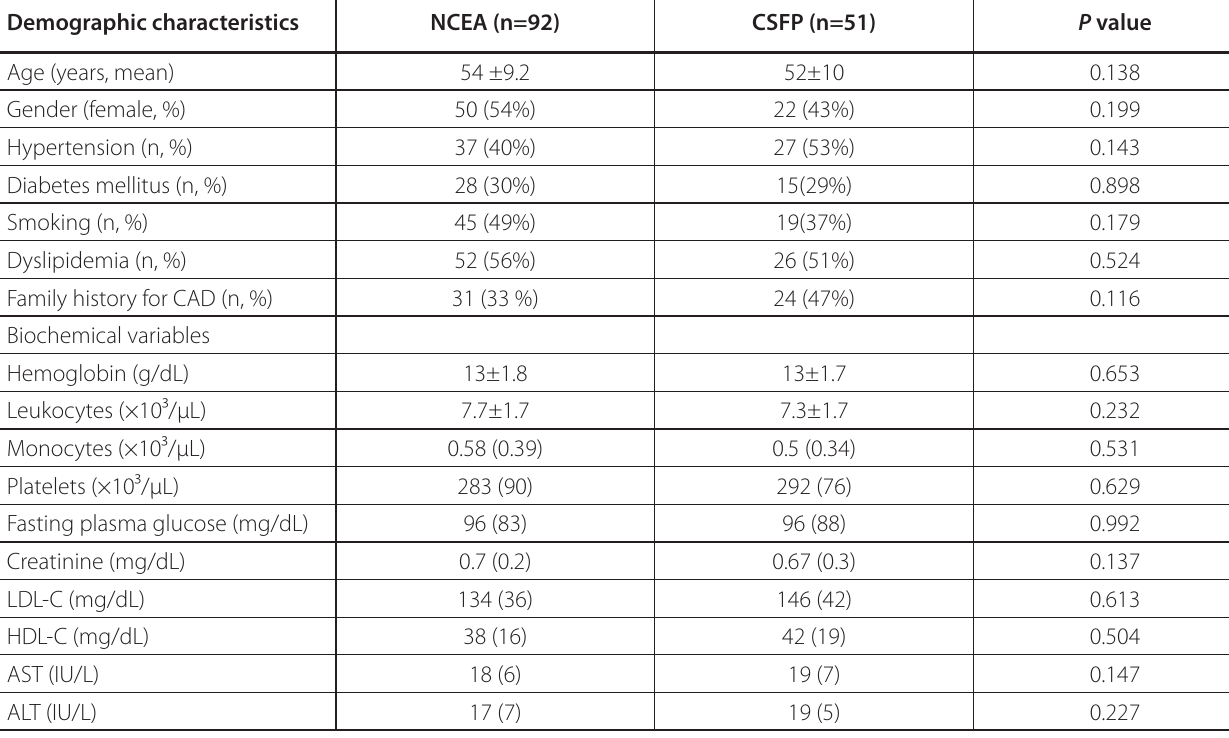
Table 4. Baseline demographic characteristics and biochemical variables of the CAE groups. Demographic characteristics